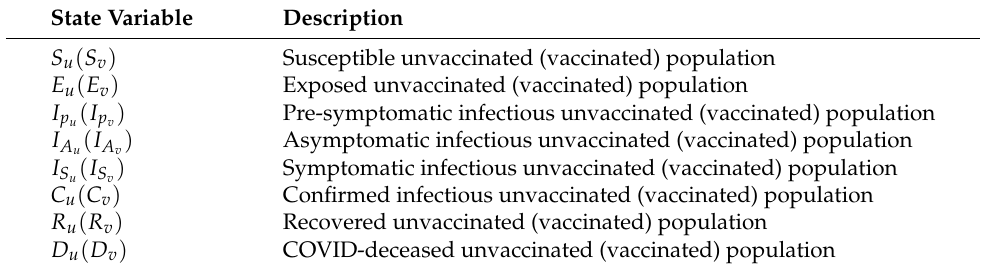
Figure 1. Flowchart of the formulated model. Table 1. State variables and their